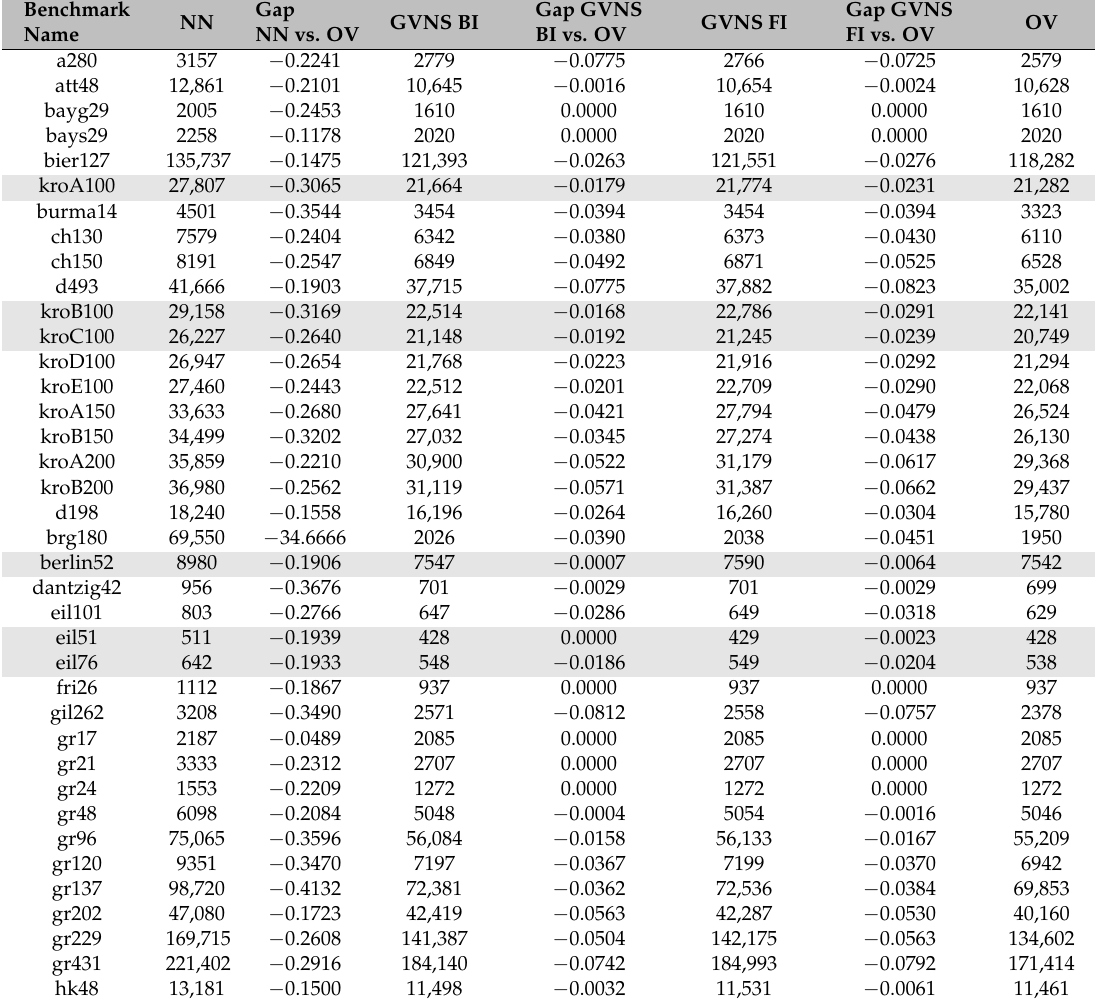
Table 1. The computational results demonstrate that novel GVNS outperforms NN on all TSP